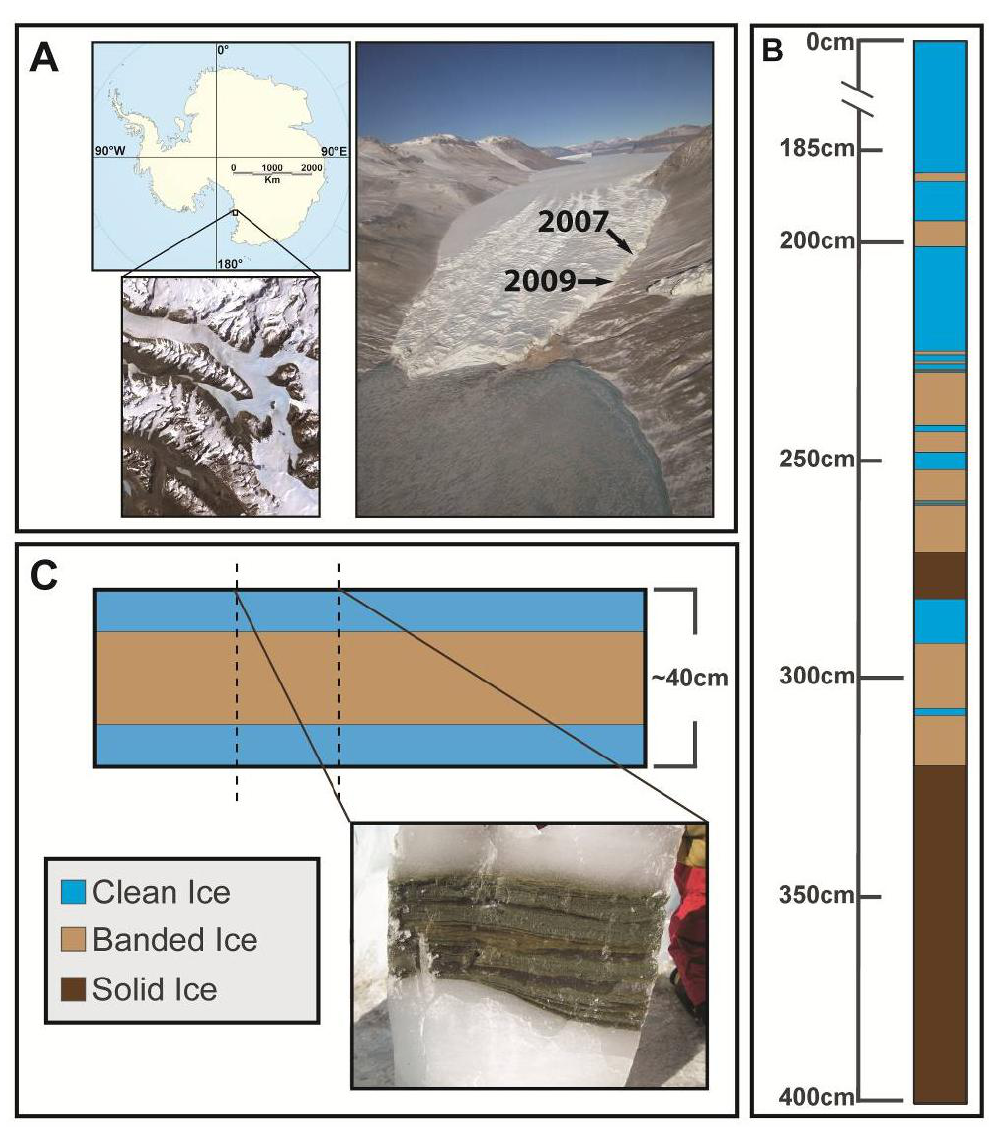
Figure 1. ( A ) Map and aerial photograph of Taylor Glacier, located in the McMurdo Dry Valleys of Victoria Land, Antarctica. The location of the 2007 and 2009 access tunnels are indicated. ( B ) Schematic of the 4 m deep basal ice profile sampled from Taylor Glacier in 2007. The top of the profile (designated 0 cm) was located in debris-poor clean ice, which was underlain by several layers of both debris-rich banded dispersed and laminated solid ice with a thick layer of basal solid ice as the lowermost unit. ( C ) Schematic of the debris-rich banded dispersed basal ice horizon sampled in